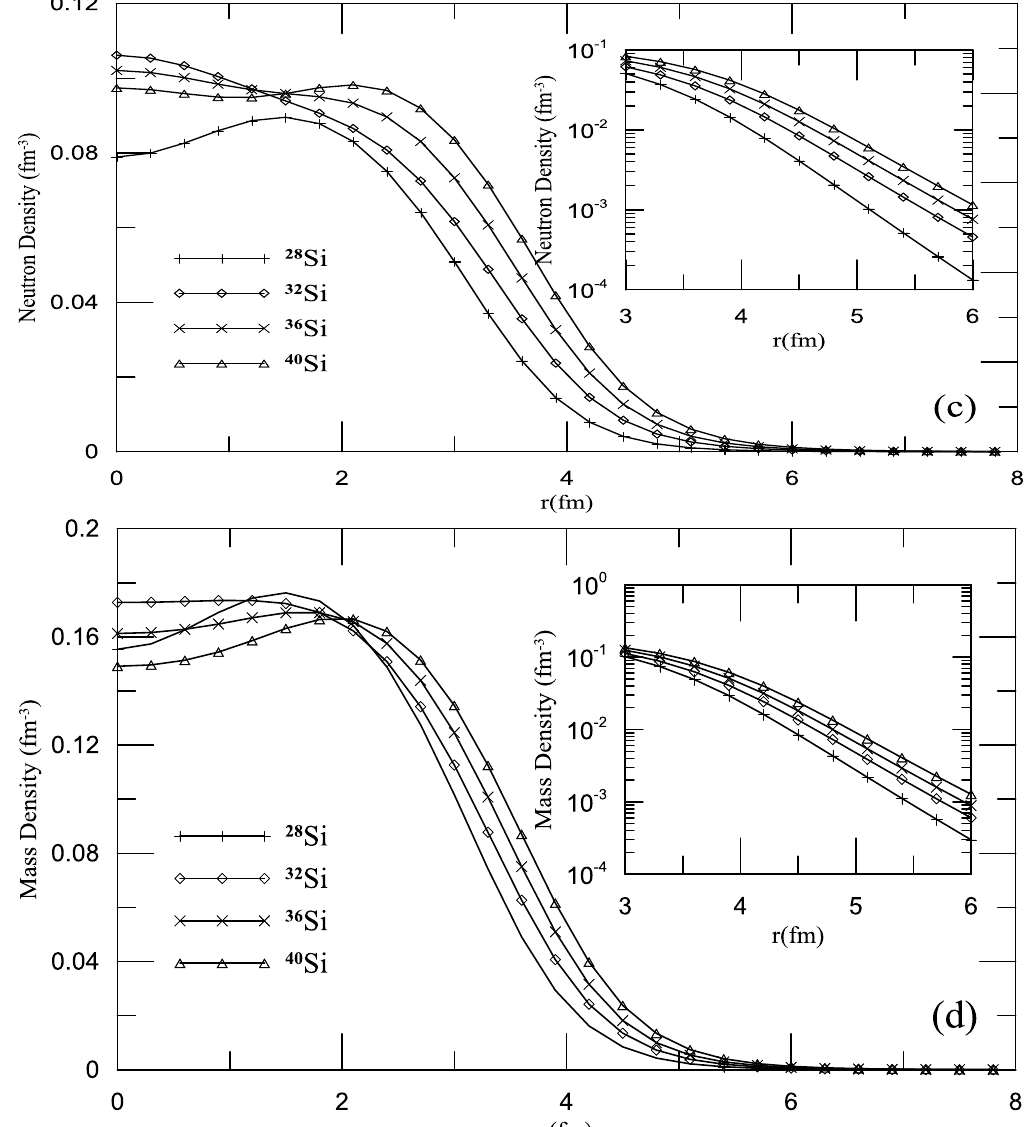
Fig. 4: Density curves of different Si- isotopes calculated by the SkX parameterization; (c) neutron density, (d) mass